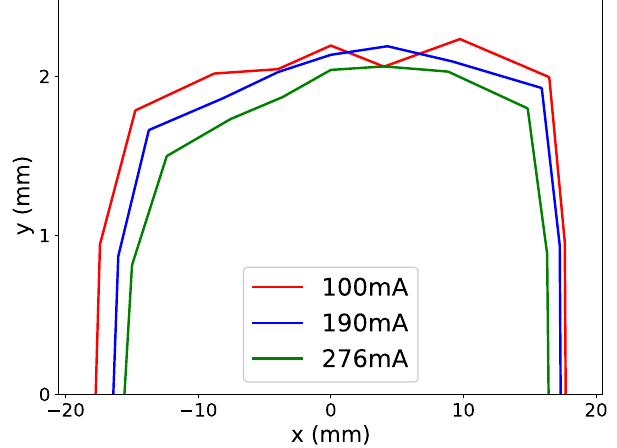
FIG. 15. Dynamic aperture reduction at different stored beam currents without linear lattice correction at NSLS-II. In addition to the quadrupole nominal settings, localized quadrupolar wake- fields are introduced in the lattice. The systematic and random multipole errors, closed orbit distortion and linear coupling are included in the simulations. Each dynamic aperture is obtained, accounting for random multipole error distributions in specific magnets, and averaged over 50 random seeds.